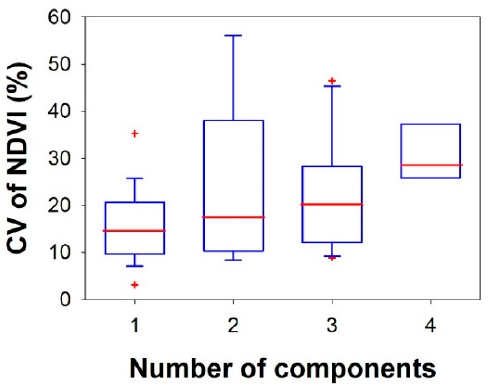
Figure 9. Box plot of the coefficient of variation of NDVI for all the FLEX pixels in both sites. Groups “1”, “2”, “3” and “4” represent FLEX pixels with the corresponding number of land cover components.